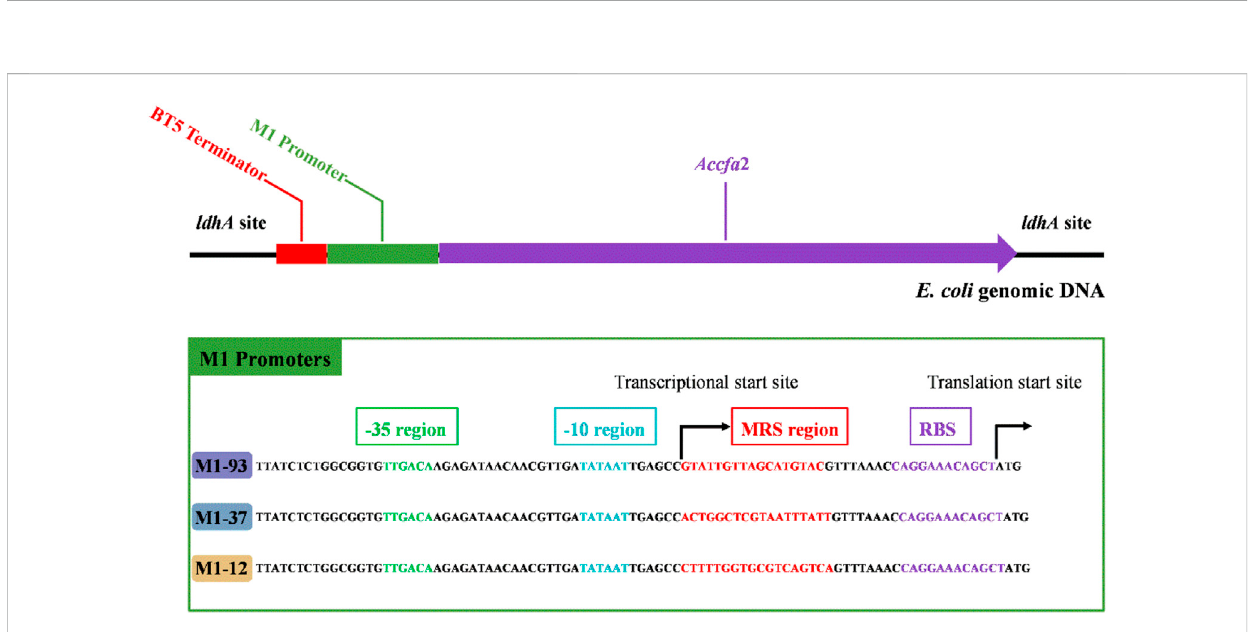
FIGURE 2 Integration of cfa 2 from A. caldus CCTCC AB 2019256 into genomic DNA of E. coli MG1655 at the ldhA (lactate dehydrogenase) site using the CRISPR-Cas9 dual-plasmid system. A BT5 terminator was introduced to eliminate the in fl uence of endogenous promoter of the ldhA gene. The three differentpromotersemployed to regulate cfa 2expressionhave thesame-35region,-10 region andRBS region,while themRS(mRNAstabling) region is distinct. See reference 4 for details on